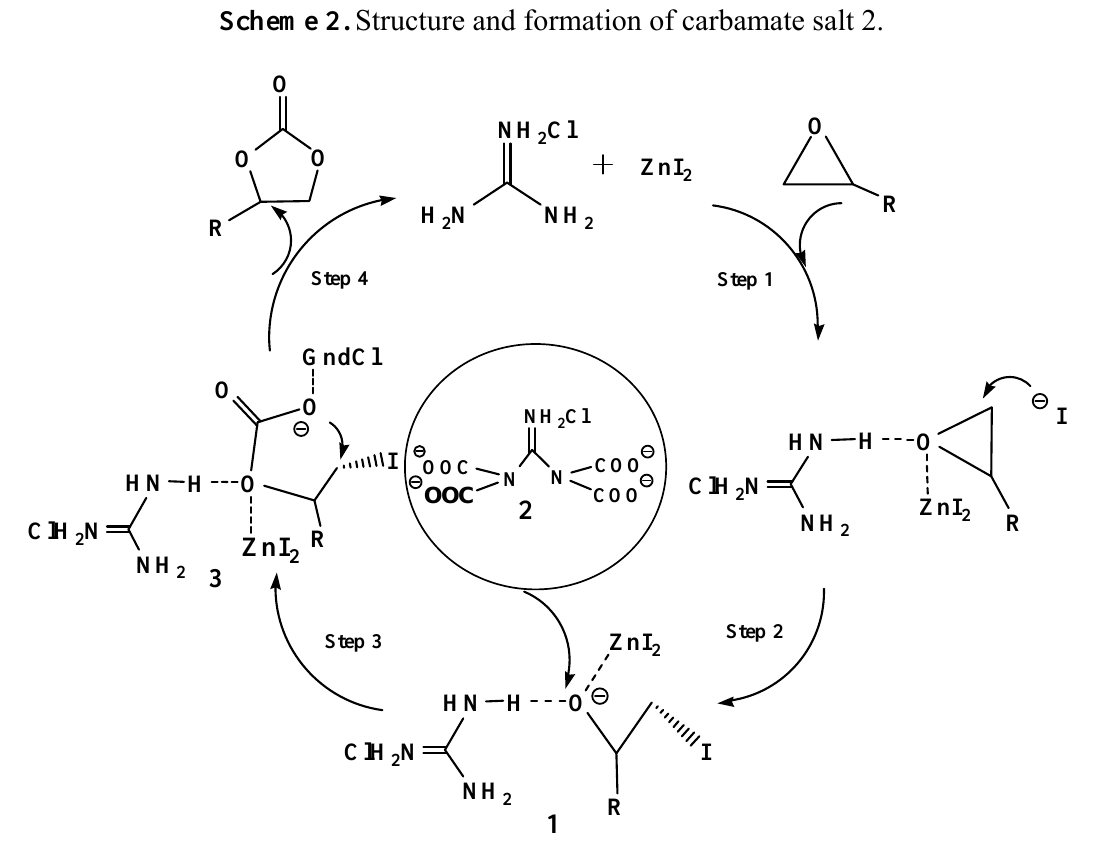
Scheme 3. Possible reaction mechanism for GndCl/ZnI 2 catalyzed cycloaddition